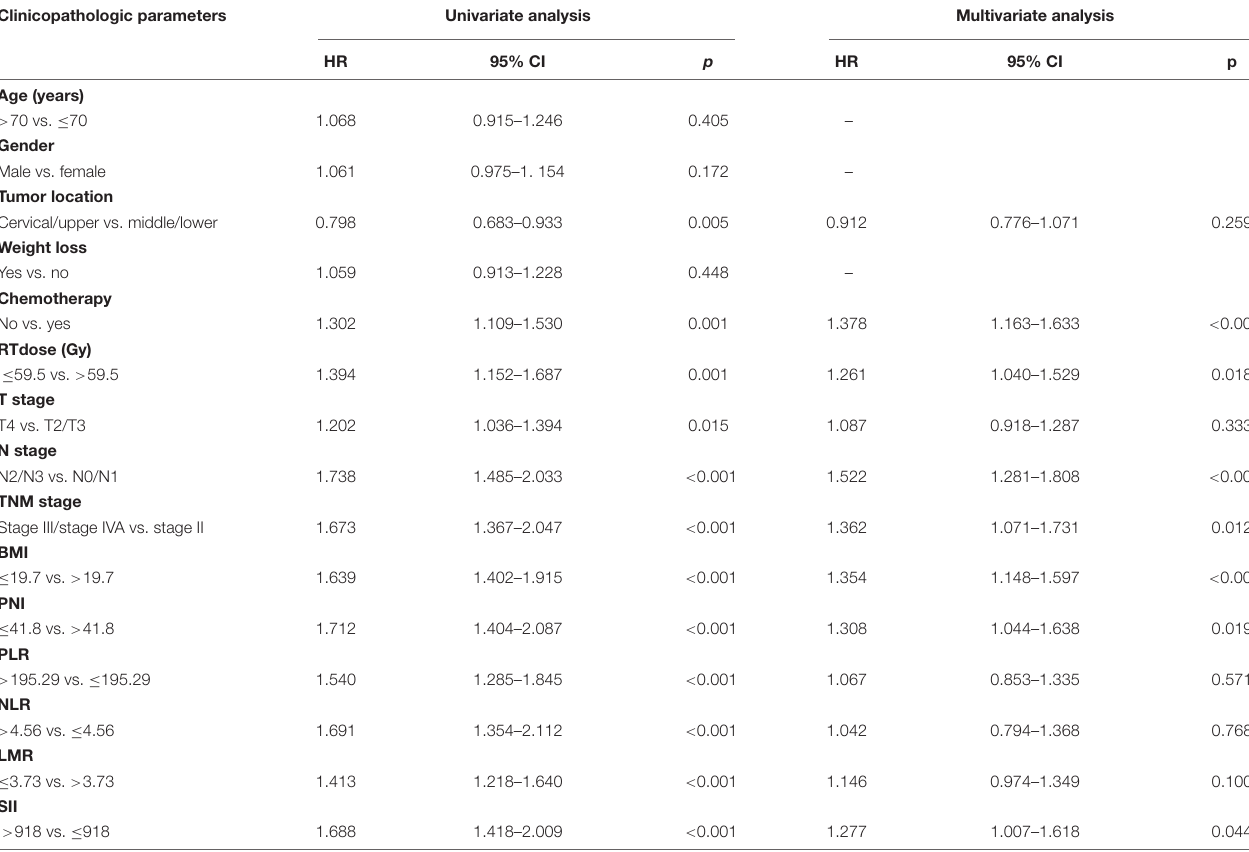
TABLE 3 | Predictors of progression-free survival: univariate and multivariate Cox proportional hazards models. Clinicopathologic